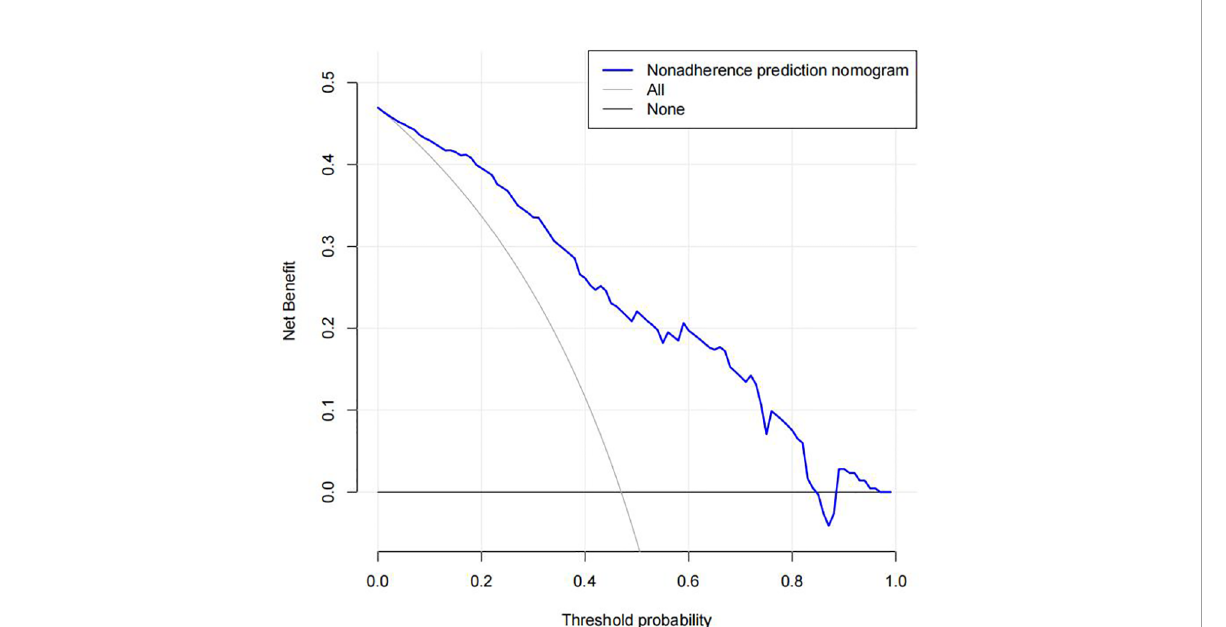
FIGURE 6 Decision curve analysis of the diabetic retinopathy (DR) nomogram. The x-axis represents the threshold probability. The y-axis represents the net bene fi t. The dotted line represents a DR risk nomogram, and the narrow solid line indicates patients presumed to have DR. The decision curve revealed that if a patient ’ s and a doctor ’ s threshold probabilities are more than 2% and 85%, respectively, using this DR nomogram in the current study to predict DR incidence risk adds more bene fi t than the intervention-all-patients